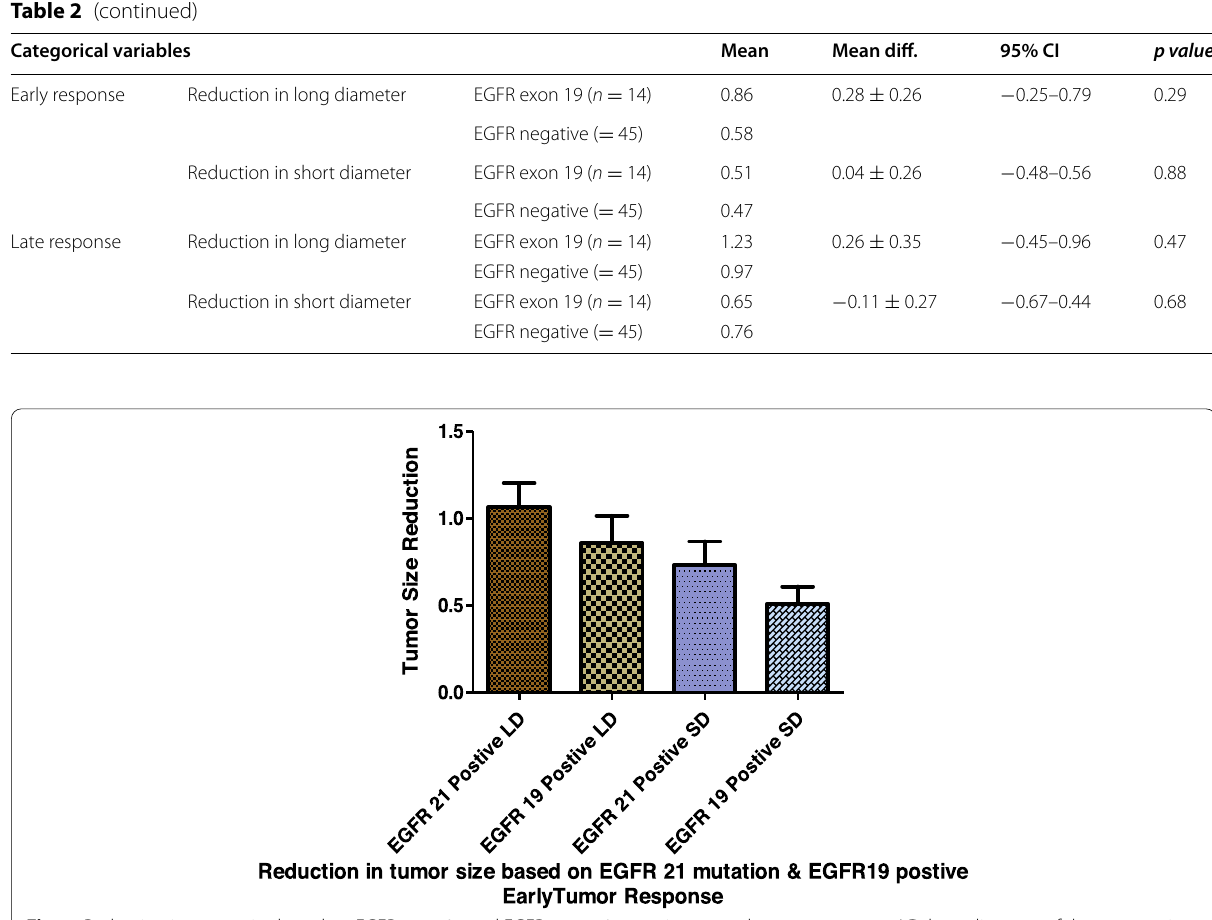
Fig. 1 Reduction in tumor size based on EGFR exon 21 and EGFR exon 19 mutations at early tumor response. LD, long diameter of the tumor axis; SD, short diameter of the tumor